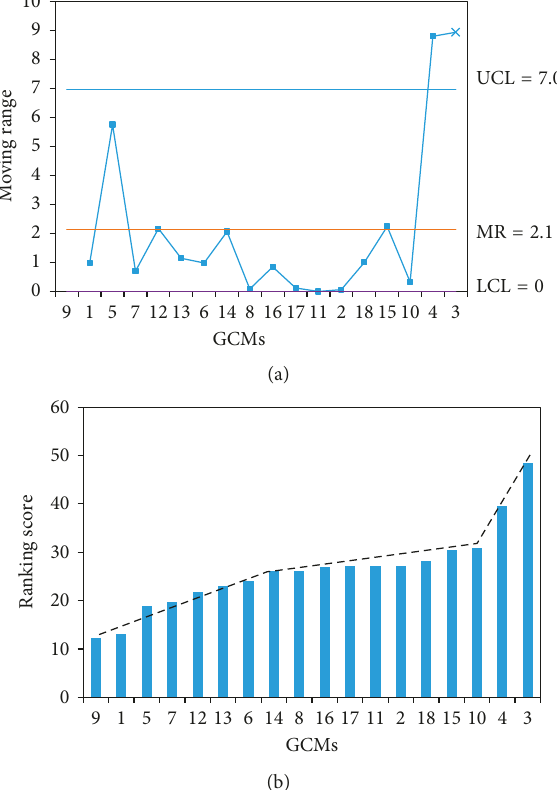
Figure 12: Moving test and breaking points of precipitation via GCMs: (a) moving range for precipitation and (b) breaking point of ranking scores for precipitation.